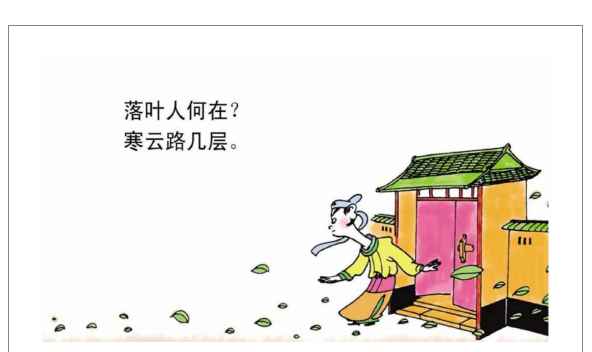
FIGURE 12 The third panel on Cai (2014, p. 143). Images reproduced with permission from Shang Dong People Press.